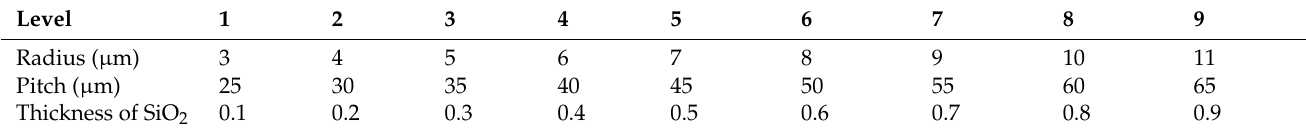
Table 2. The parameter combination factor level.